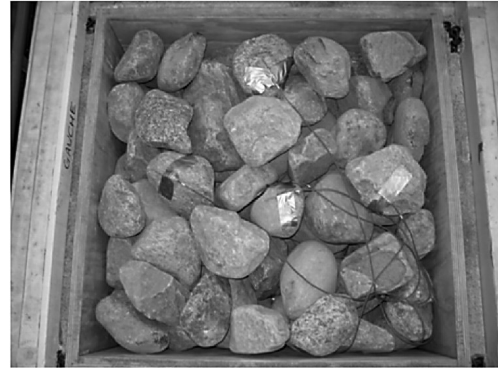
Figure 10. Experimental setup during filling process (Fillion et al., 2011 [7]).